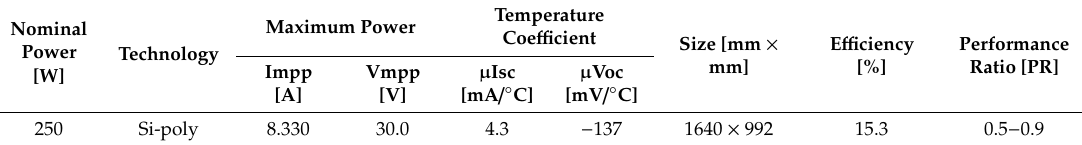
Table 3. Specifications of the simulated PV module.